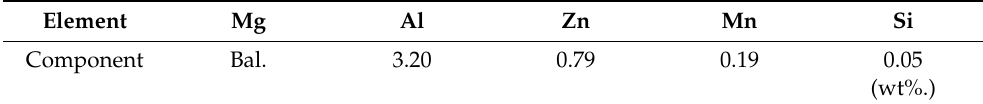
Table 1. Chemical composition of AZ31 alloy used in this study. Element Mg Al Zn Mn Si Component